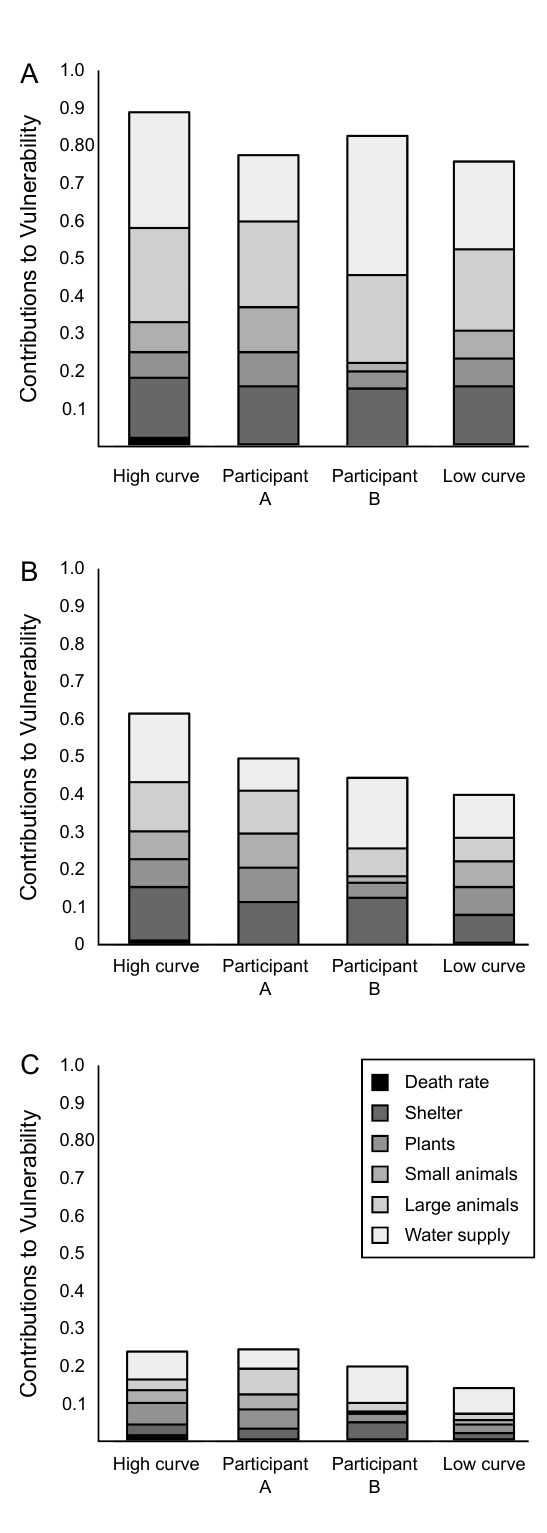
Figure 7: The contributions to vulnerability from the six fields for [A] 20 cm of LST; [B] 10 cm LST; and [C] 5 cm of tephra. Left-hand columns use the high vul- nerability curves shown for each of the six fields in Ap- pendix A; right-hand columns use the low vulnerability curves, while the two central columns indicate the con- tributions assessed by Participants A and